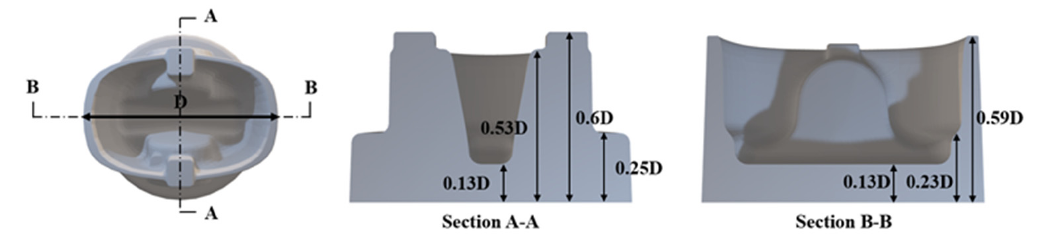
Figure 17. Piston head forging and dimensions.